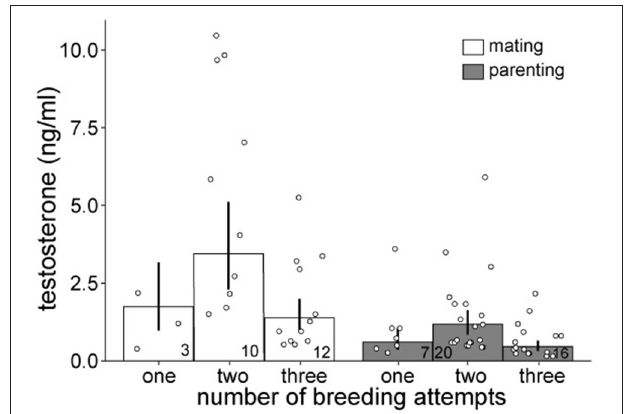
FIGURE 1 | Back-transformed posterior mean circulating testosterone concentrations (and 95% credible intervals) of male stonechats caught during the mating and the parental phase of the breeding cycle in relation to the total number of breeding attempts. Open dots represent raw data. Sample sizes are indicated within bars. If the 95% credible intervals of one group do not overlap with the mean estimate of another group, a meaningful difference between the groups can be assumed.